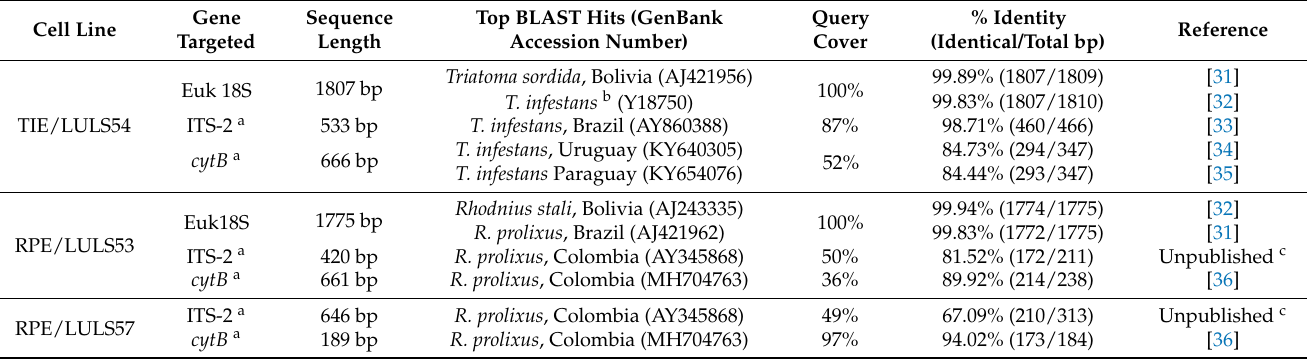
Table 1. Confirmation of species origin of Triatoma infestans cell line TIE/LULS54 and Rhodnius prolixus cell lines RPE/LULS53 and RPE/LULS57. Closest identity with published sequences in GenBank obtained by BLAST analysis of sequences amplified using PCRs targeting Eukaryotic 18S (Euk 18S) and triatomine rDNA second internal transcribed spacer (ITS-2) and cytochrome B ( cytB ) genes.